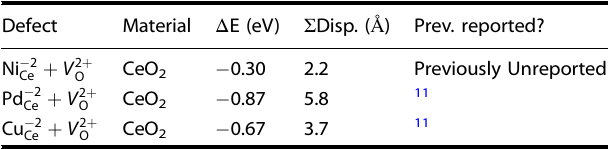
a Metastable and ground state structures with bond distance labelling shown in Supplementary Fig.